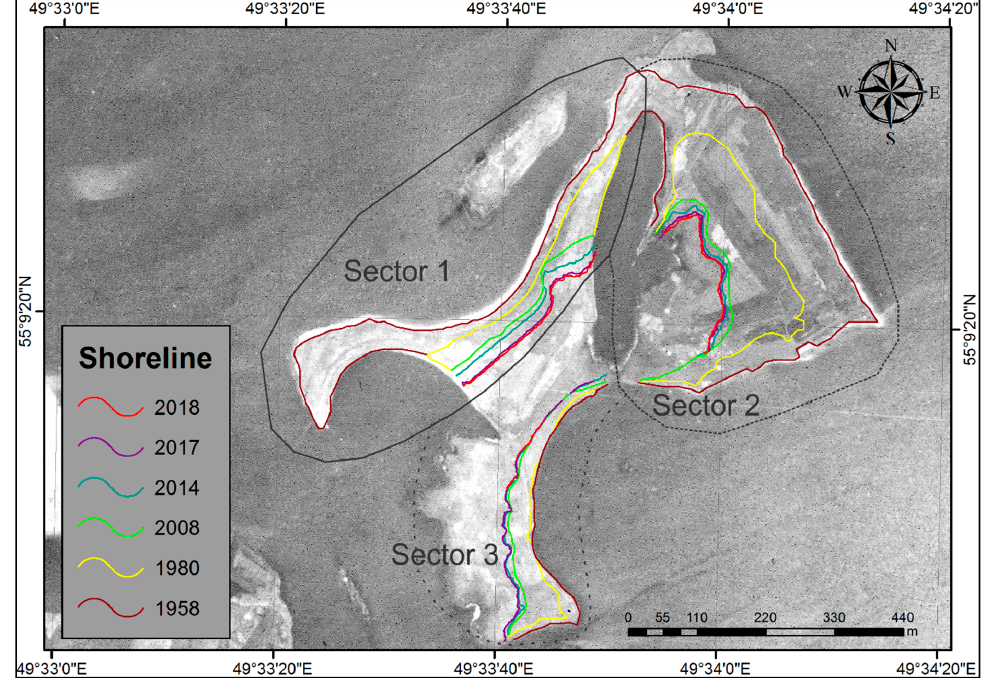
Figure 7. Shoreline limit resulted from cartographic analysis and field surveys and the division of the three analysed sectors.